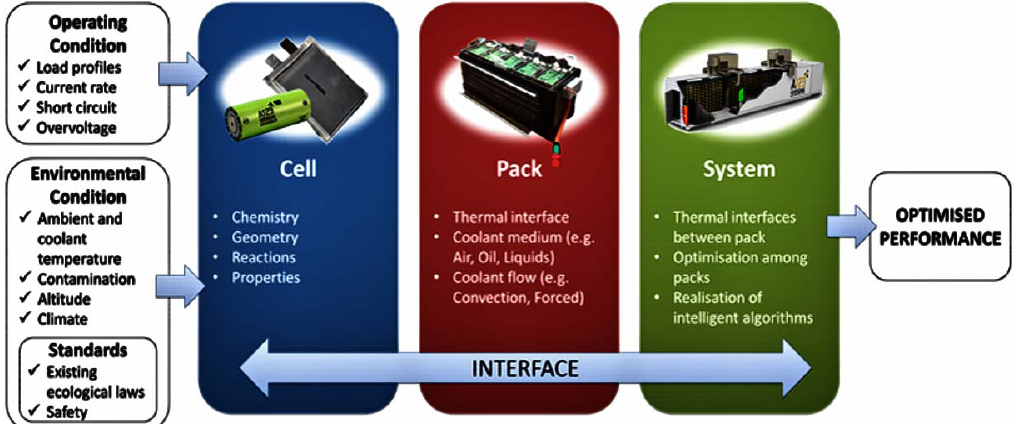
Figure 1. Battery thermal management system (BTMS).